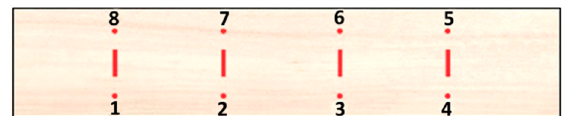
Figure 1. Points on the samples for measuring colour (dots) and roughness (lines).